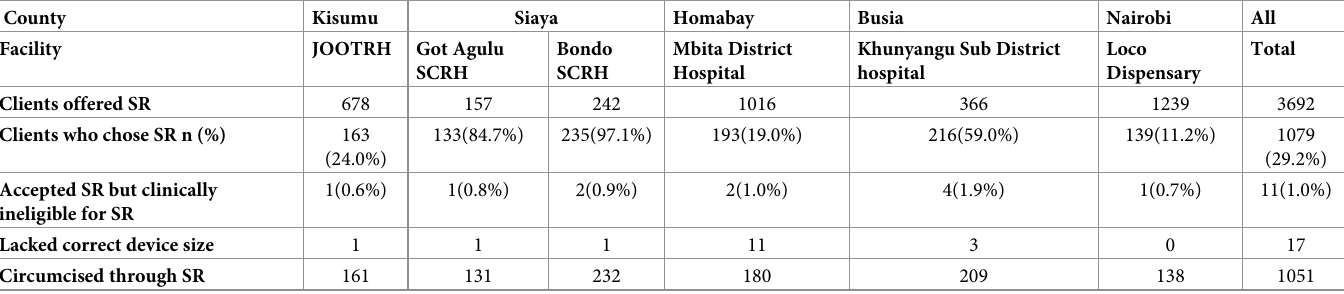
Table 2. ShangRing client recruitment, screening and enrollment cascade.